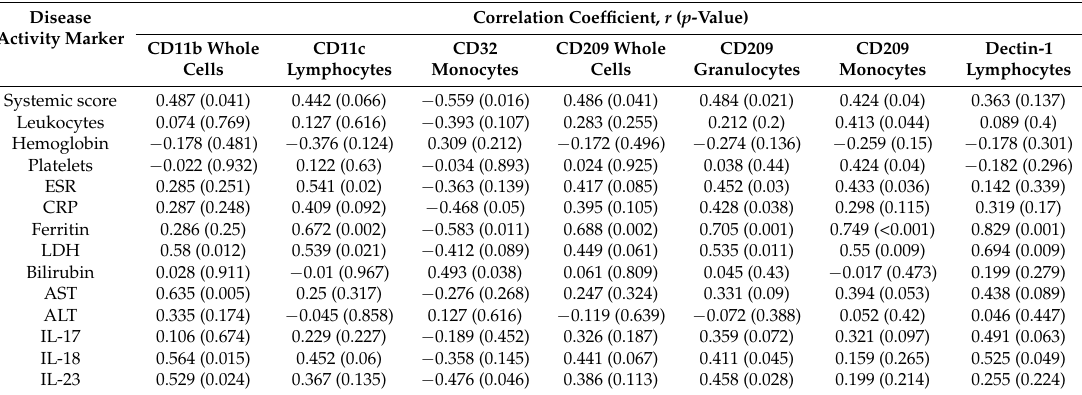
Table 2. Correlations between the frequencies of stained cells presenting several markers and disease activity markers in patients with adult-onset Still’s disease.